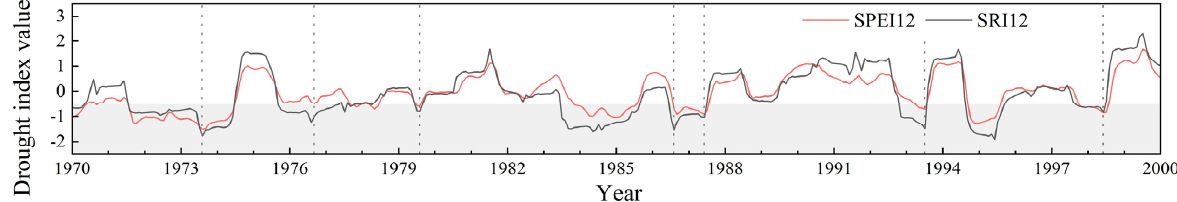
Figure 6. Comparison curve of SPEI12 and SRI12 in the same period in the LNB. Drought events